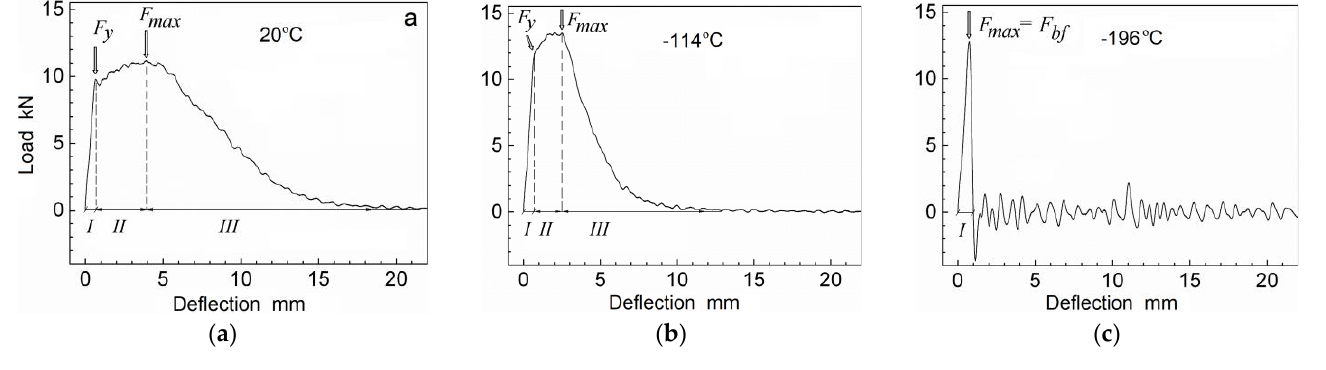
Figure 6. The impact loading diagrams for the Charpy-V specimens tested at T = 20 °C ( a ), T = − 114 °C ( b ) and T = − 196 °C ( с ). T = − 114 ◦ C ( b ) and T = − 196 ◦ C ( c